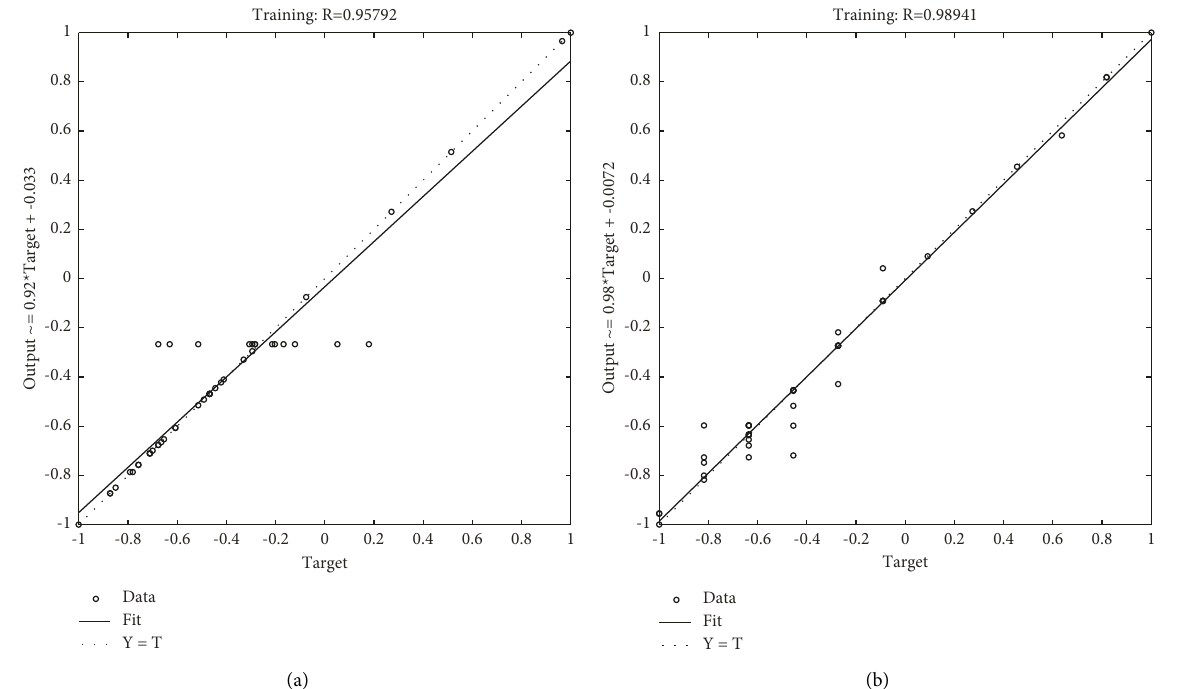
Figure 7: Accuracy of neural network training for scenario (1): (a) shows online shopping and (b) shows offline shopping.